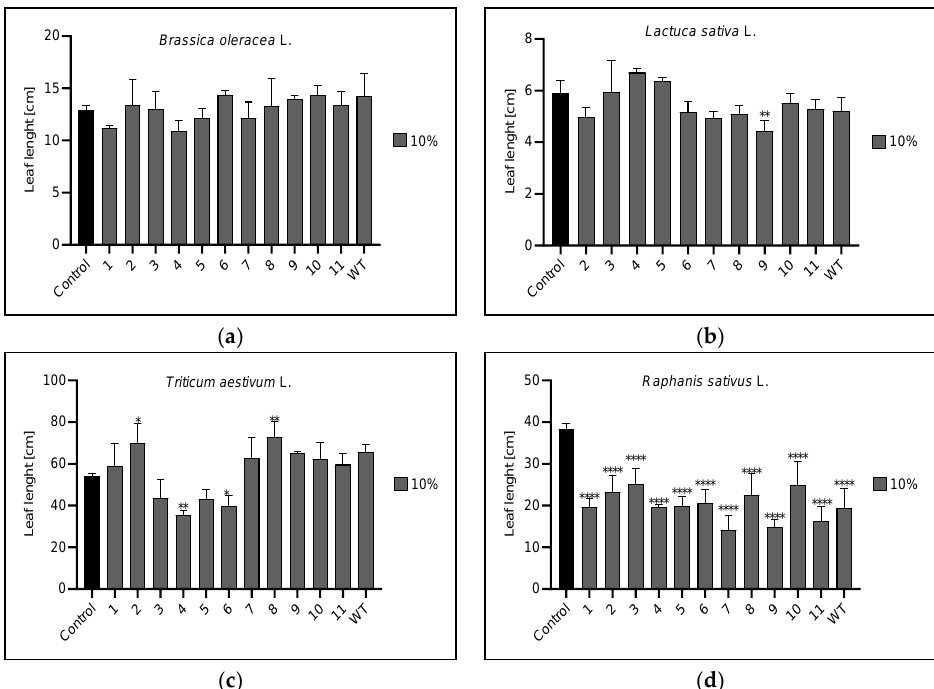
Figure 10. Leaf length of broccoli ( a ), lettuce ( b ), wheat ( c ), and radish ( d ) sprouts treated with 10% concentration for all algae clones tested (1-11, WT) and control (Control). Values represent mean ± SD, n = 10 plants, * p < 0.1, ** p < 0.01, **** p < 0.0001 compared to control (ANOVA and Dunnett ’ s a posteriori test).